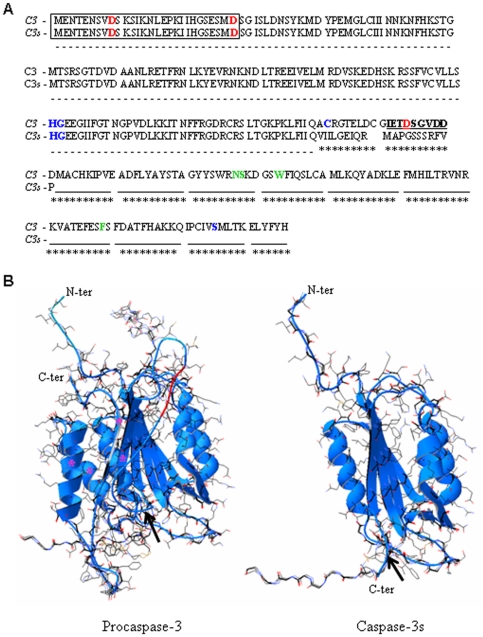
Protein sequence and 3D structure of procaspase-3 and caspase-3s.
A. Alignment of procaspase-3 (C3) and caspase-3s (C3s) amino acid sequences. Prodomain is framed, amino acids forming the catalytic site are in bold blue, interaction sites with caspase-3 inhibitors are in bold green [27]–[28], cleavage site between small and large subunits are in bold and underlined [28], aspartate residue cleaved during activation are in bold red [29]. B. 3D structure of procaspase-3 and caspase-3s. Bold arrows represent the end of common sequence between both proteins and pink asterisks show the β-sheets and α-helixes present in procaspase-3 and absent in caspase-3s.